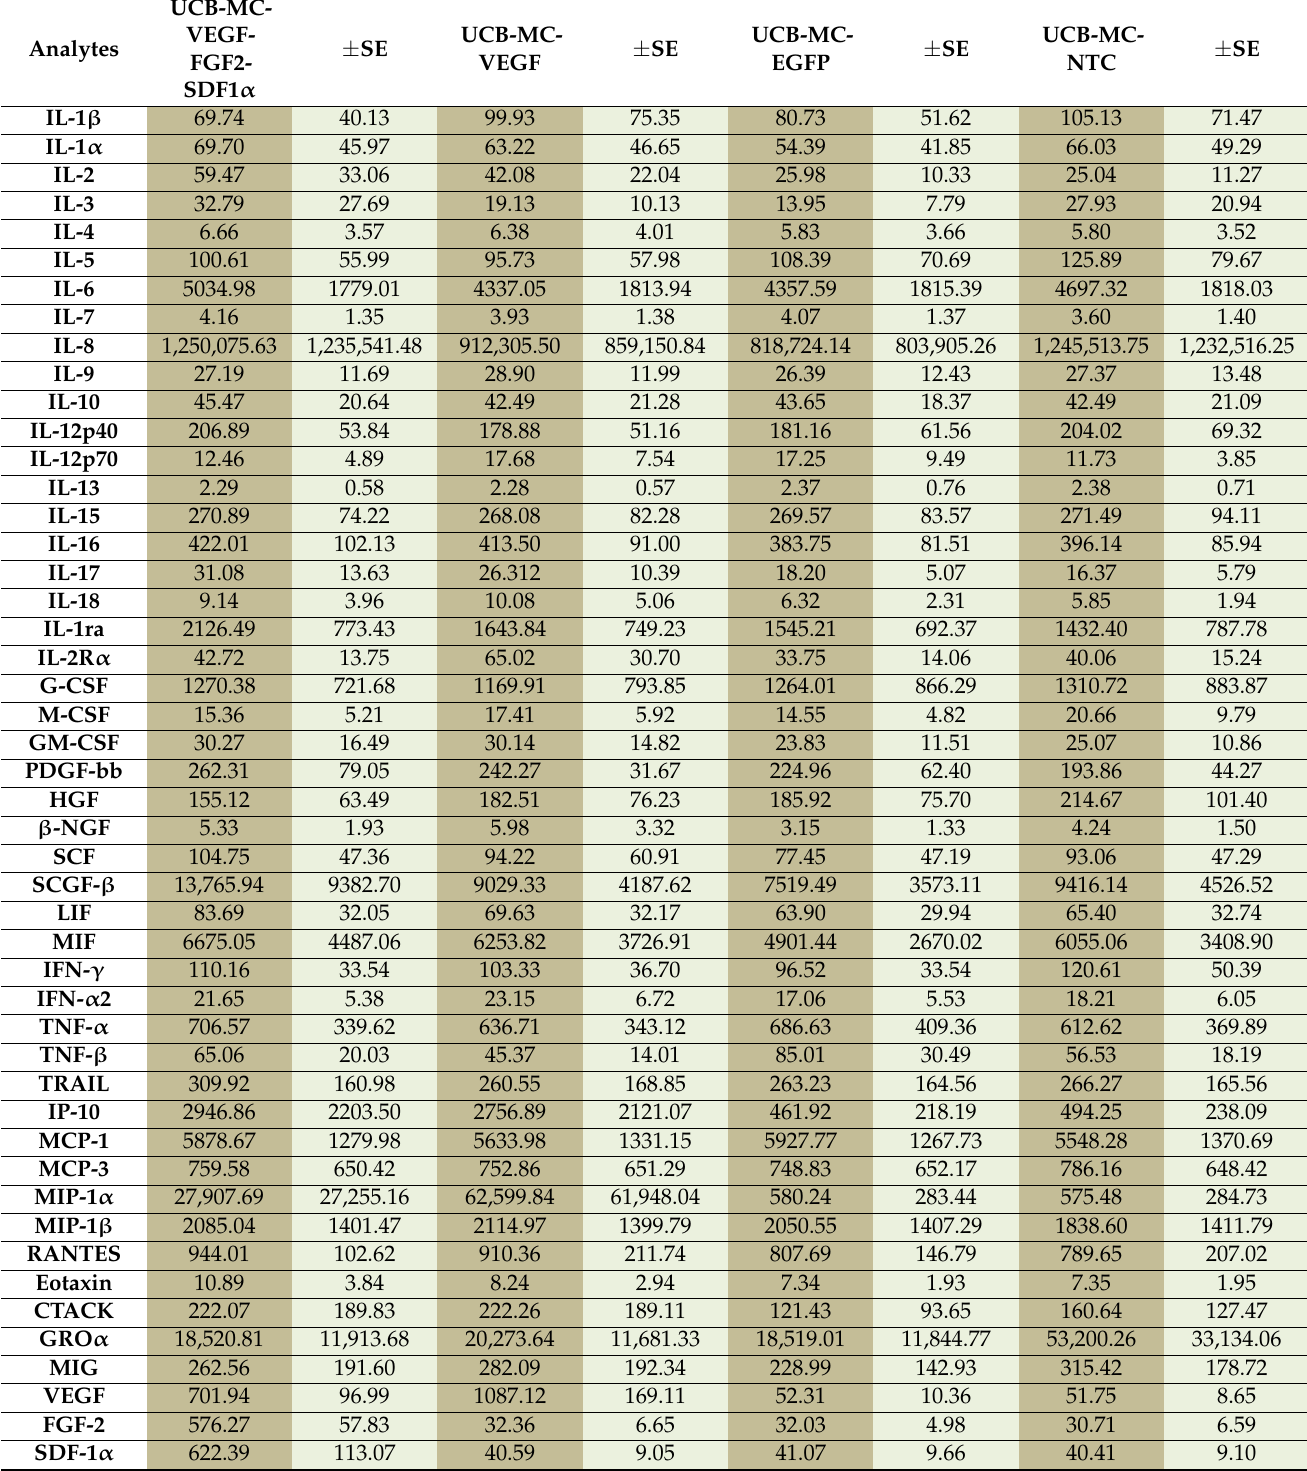
Table 1. Profile of cytokines, chemokines, and growth factors secreted by genetically modified human umbilical cord blood mononuclear cells